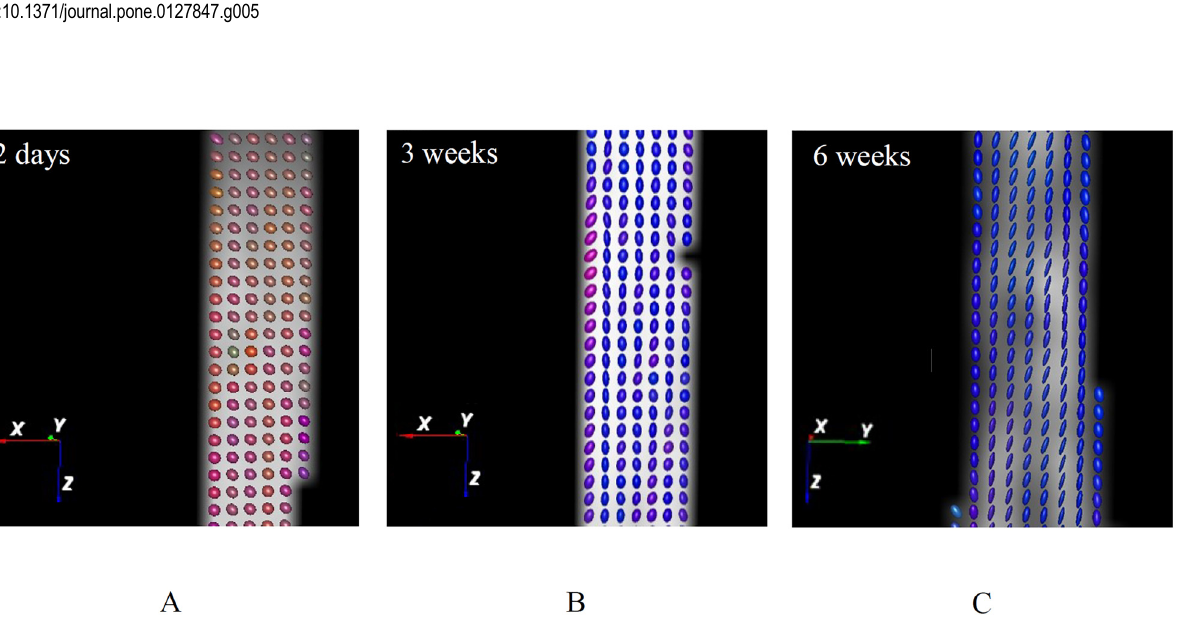
PLOS ONE | DOI:10.1371/journal.pone.0127847 May 27,